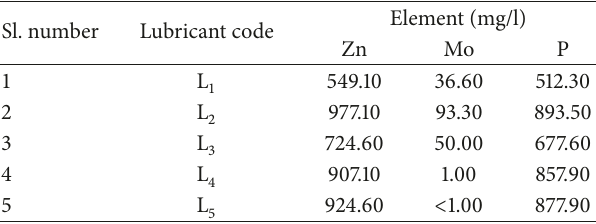
Table 4: Trace metal